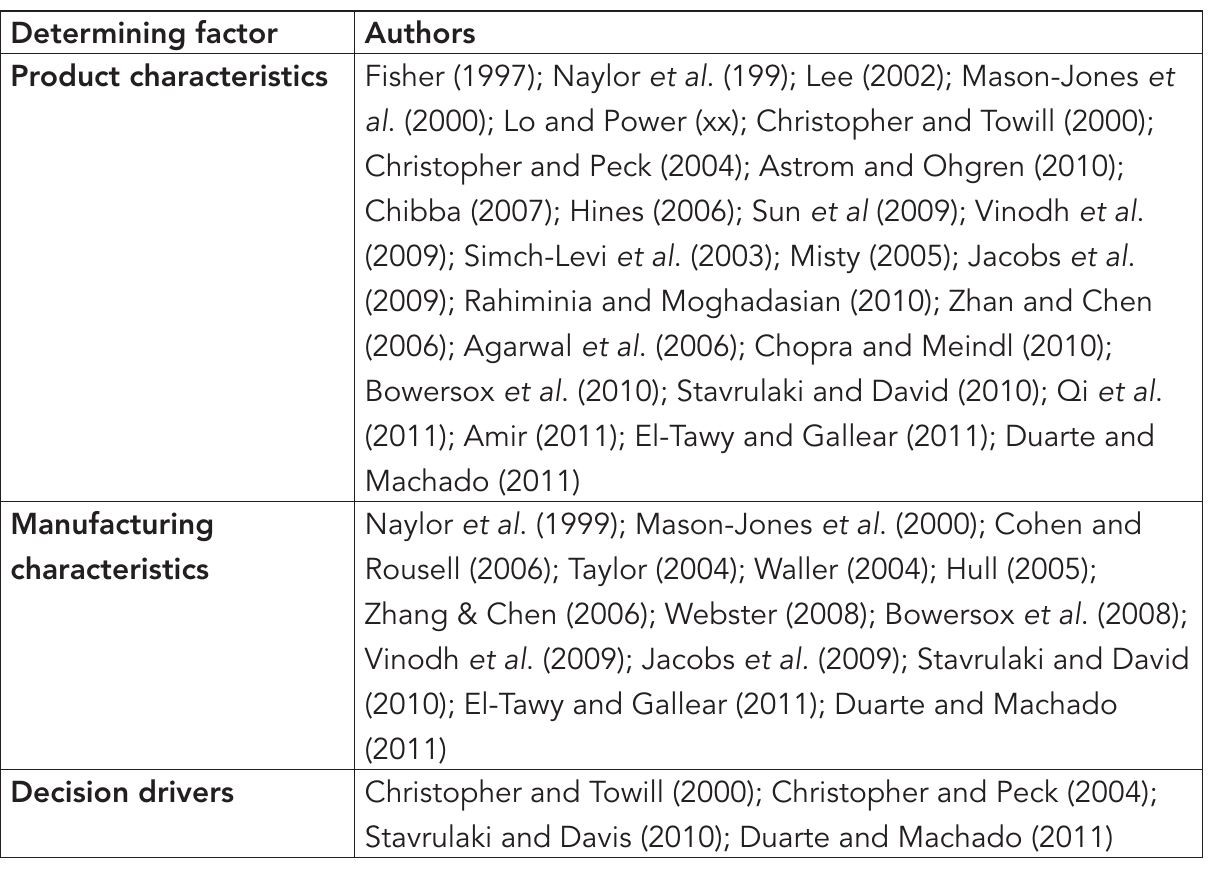
Table 3: Determinant factors for supply chain